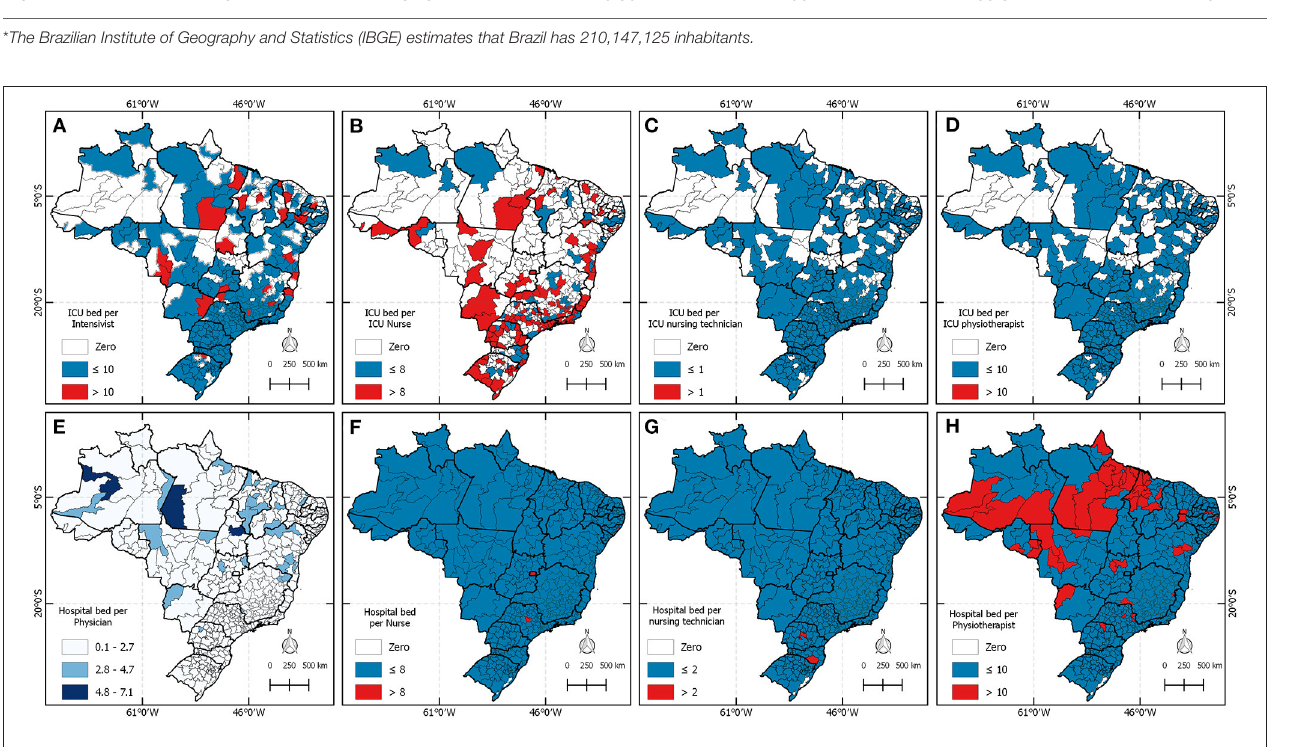
Frontiers in Public Health |